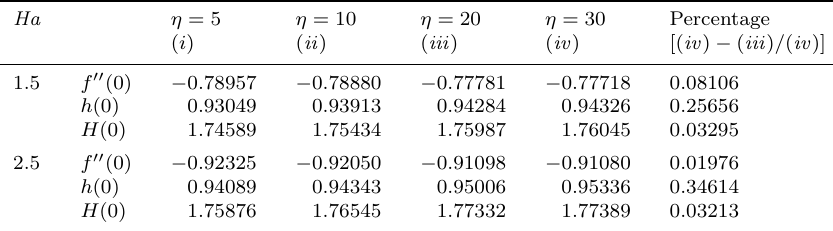
Table 4. Calculation of absolute error for f (cid:48)(cid:48) (0), h (0), H (0).